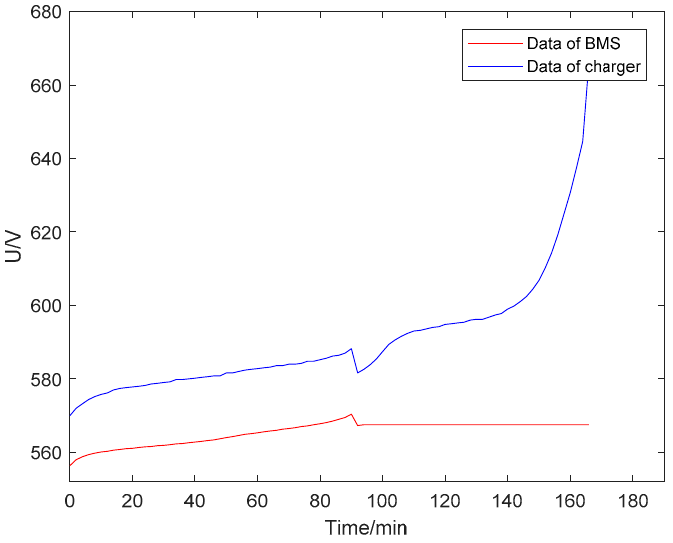
Figure 14. Comparison of voltage data provided by charger and voltage data provided by BMS.